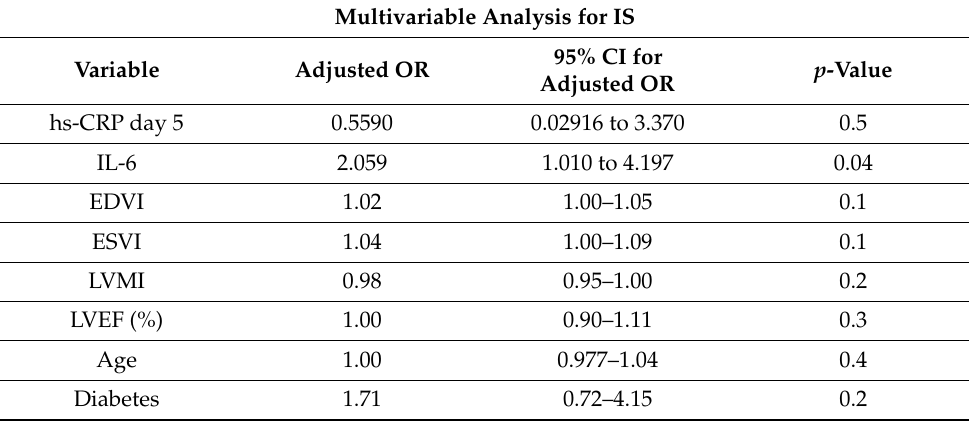
Table 7. Multivariable logistic analysis for prediction of IS and 2-year mortality.